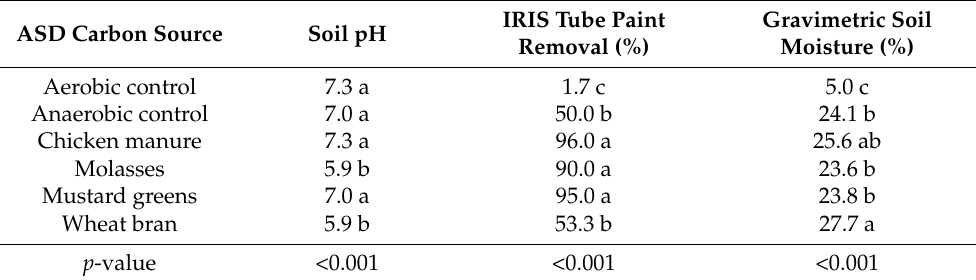
Table 2. Soil pH, iron oxide paint removal from Indicator of Reduction in Soils (IRIS) tubes, and gravimetric soil moisture percentage affected by anaerobic soil disinfestation (ASD) with different carbon sources under growth chamber conditions.